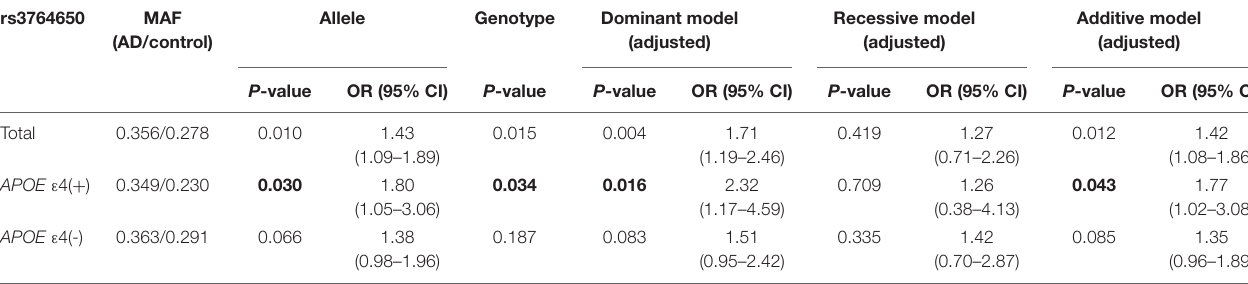
TABLE 2A | Association of rs3764650 of ABCA7 gene with AD risk stratified by APOE ε 4 status. rs3764650